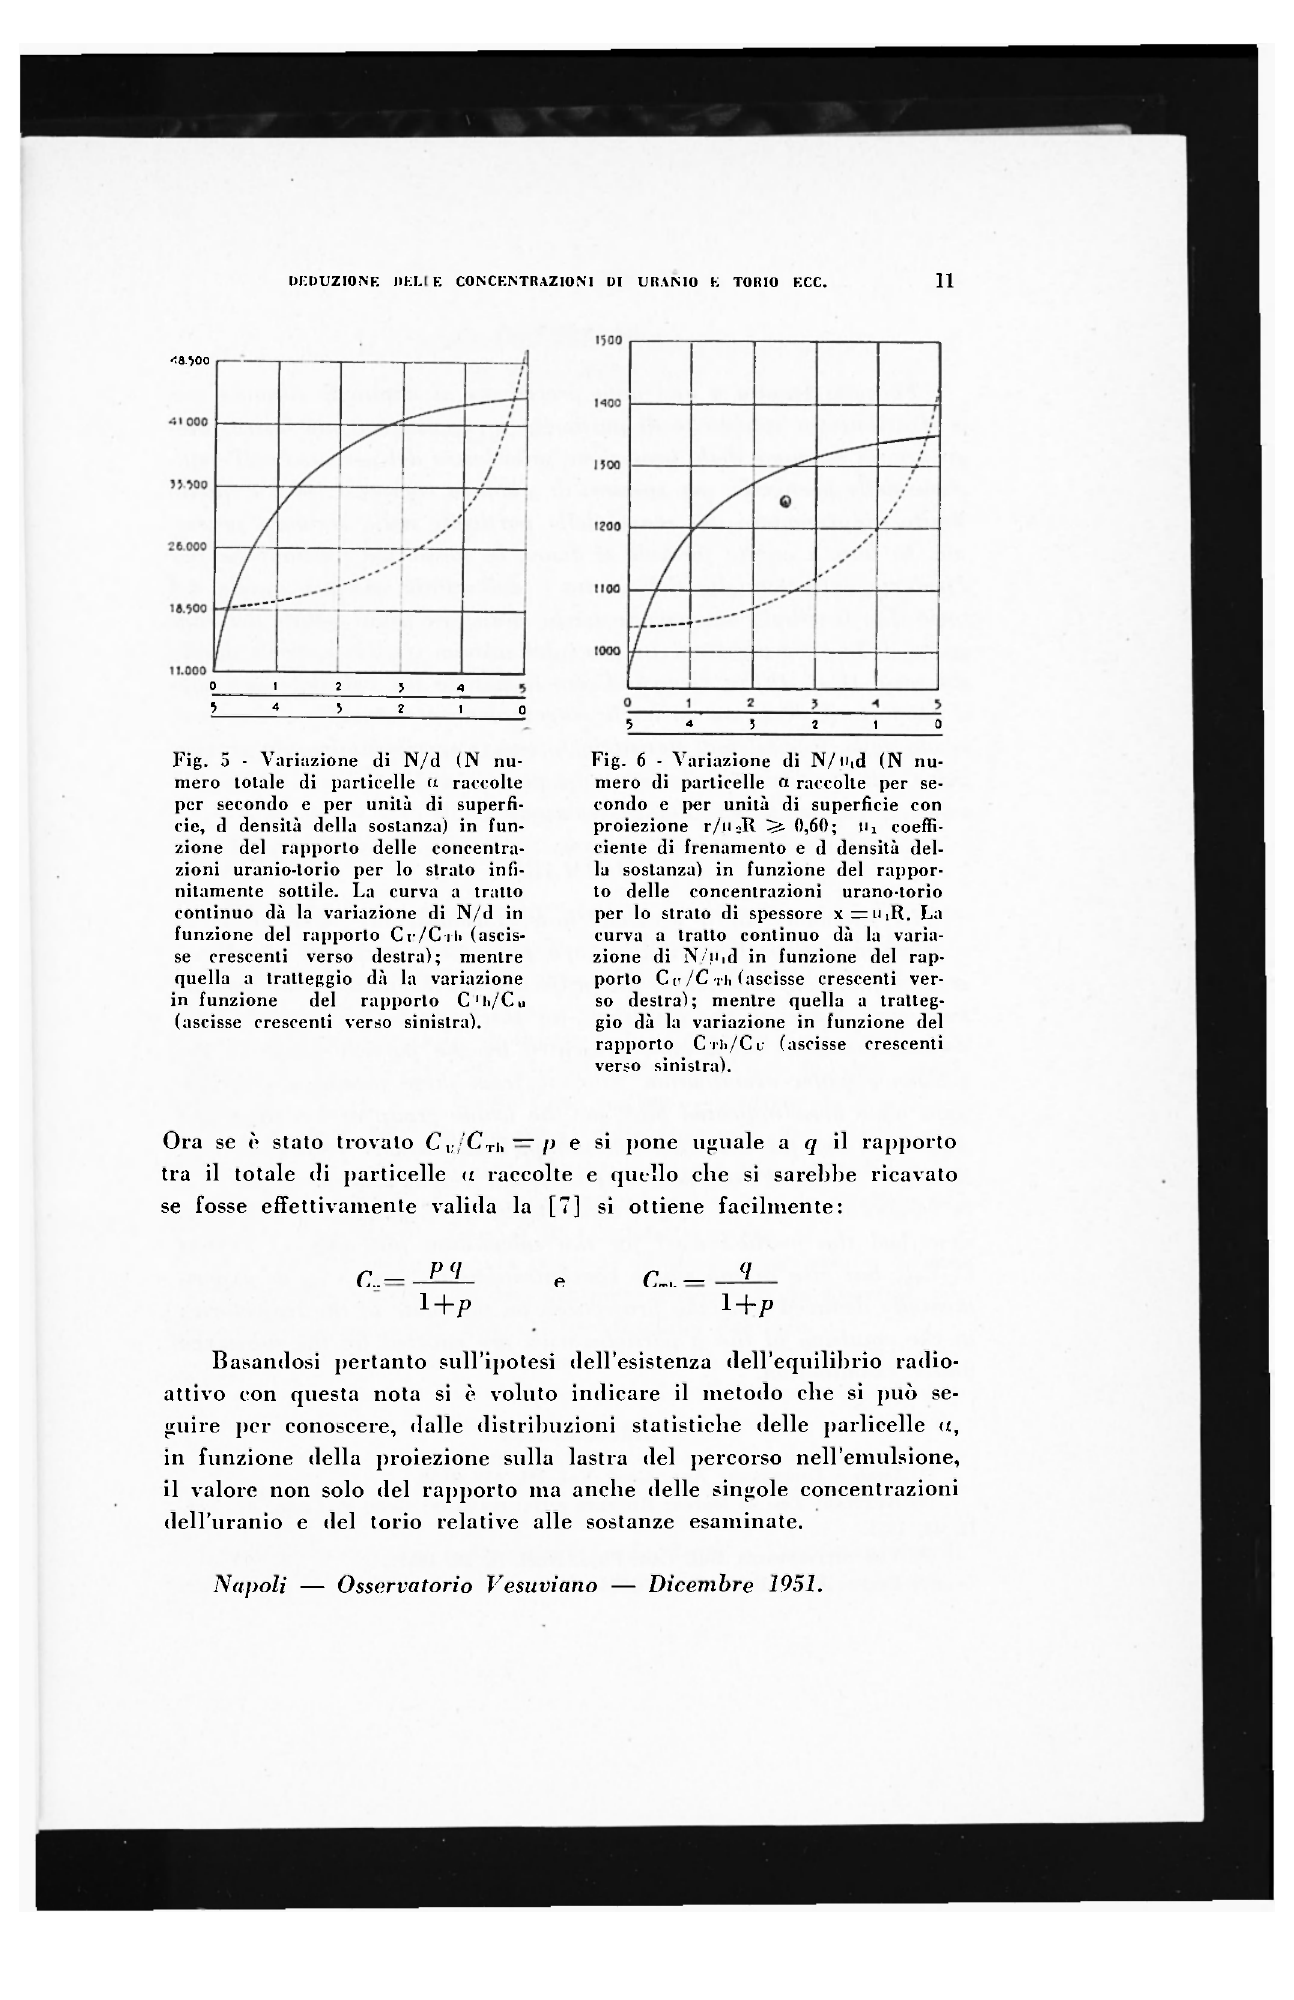
Fig. 5 - Variazione di N/d (N nu- mero totale di particelle « raccolte per secondo e per unità di superfi- cie, d densità della sostanza) in fun- zione del rapporto delle concentra- zioni uranio-torio per lo strato infi- nitamente sottile. La curva a tratto continuo dà la variazione di N/d in funzione del rapporto Cr/C i li (ascis- se crescenti verso destra);